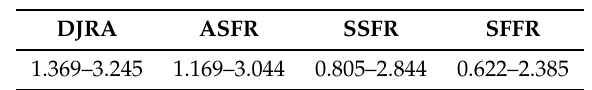
Table 3. Numerical analysis (Mbps).